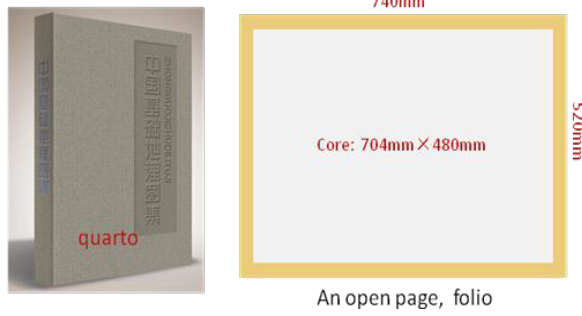
Figure 2. the page gauge of the National Geomatics Atlas